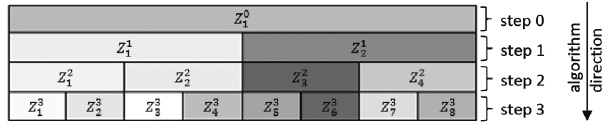
Fig. 1. The generation of cells with LAS